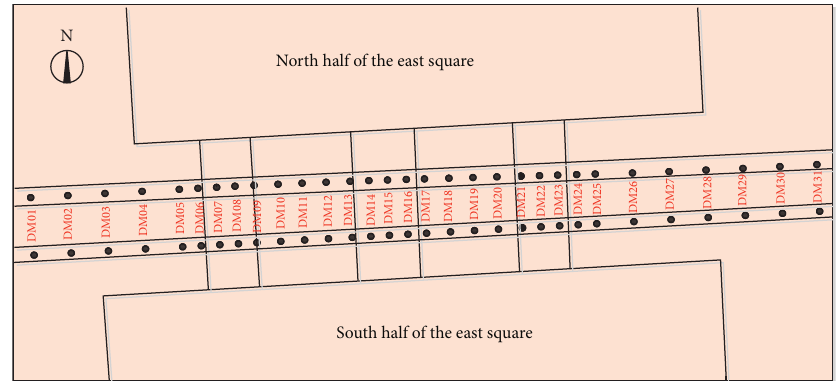
Figure 7: Distribution of automatic monitoring sections in the tunnels.